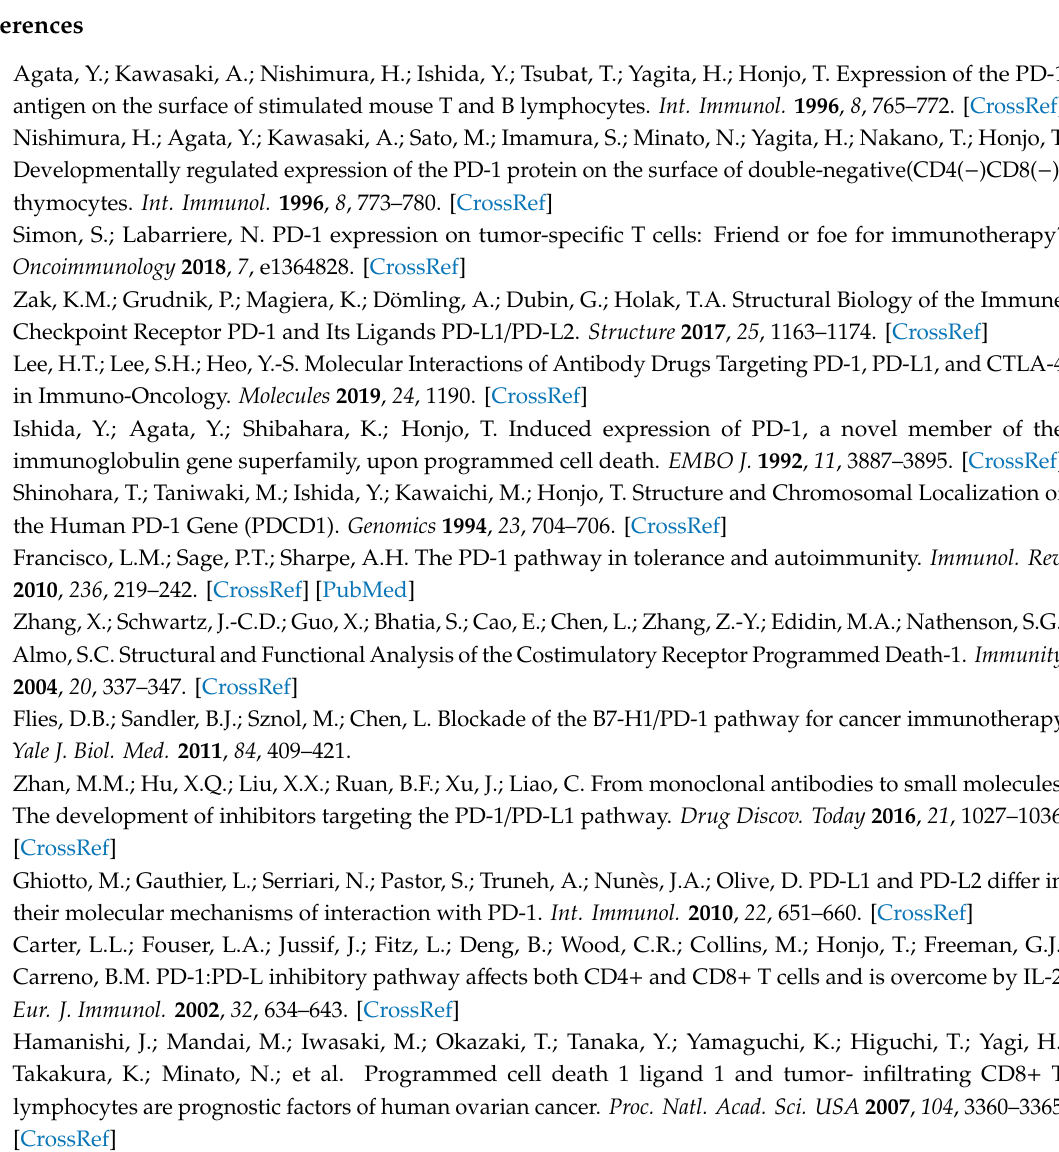
Figure S1: The protein-protein interaction between the T-cell programed cell death protein-1 (PD-1) and the cancer cell borne programed cell death protein ligand-1 (PD-L1) keeps T cells from killing tumor cells in the body (left panel). Killing tumor cells by T cells can be accomplished by blocking the binding of PD-L1 to PD-1 with immune checkpoint inhibitors (ICIs) (anti-PD-L1 or anti-PD-1) (right panel)., Figure S2: The simplified concept of noncellular Assay Techniques described in the manuscript. ( A ) HTRF (Homogeneous Time Resolved Fluorescence) ( B ) ELISA (Enzyme-Linked Immunosorbent Assay) ( C ) AlphaLISATM human PD-1 / PD-L1 binding assay ( D ) Amplified Luminescent Proximity Homogeneous Assay (ALPHA)., Figure S3: The concept of the cellular Assay Techniques described in the manuscript. ( A ) INF γ -release assay ( B ) The PD1 / PDL1 Blockade Bioassay ( C ) The T-cell proliferation assay., Table S1: The list of abbreviations used in the manuscript together with short explanation of biological terms., Table S2: Structures and references to source materials of compound mentioned in the main